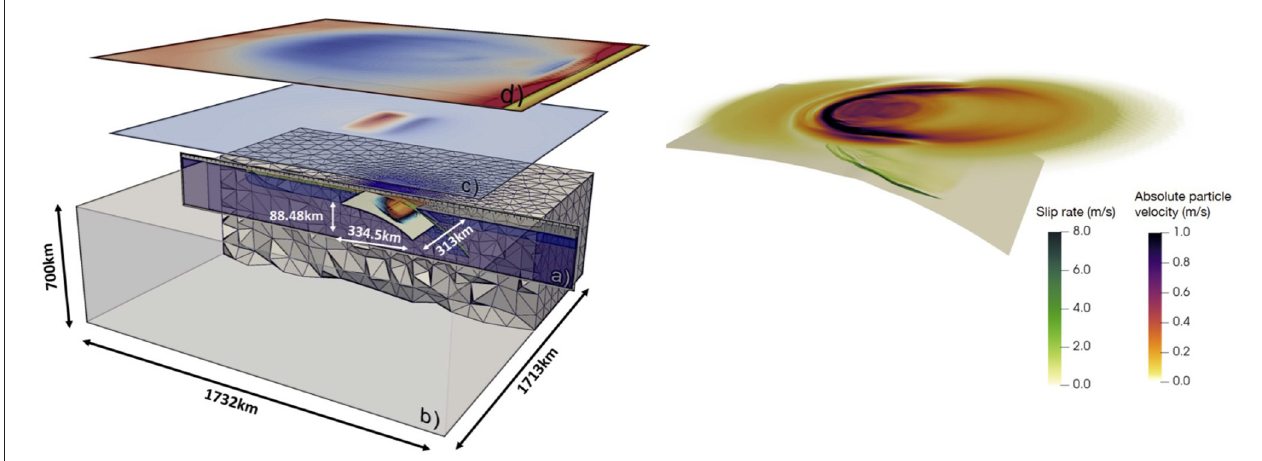
FIGURE 1 | (Left): Adapted from Madden et al. (2020) (a) sketch and dimensions of the one-way linked 2D geodynamic subduction model, (b) the 3D dynamic rupture earthquake model, (c) the dynamic rupture seafloor displacement, and (d) the 2D tsunami model, modified from Madden et al. (2020). The 3D unstructured tetrahedral mesh of the dynamic rupture model (b) is shown in gray. (Right) Snapshot of slip rate across the 3D subducting interface (greenish colors) and the seismic wavefield recorded at the free surface in terms of absolute velocity (warm colors). This snapshot is extracted from model 3B after 40 s simulation